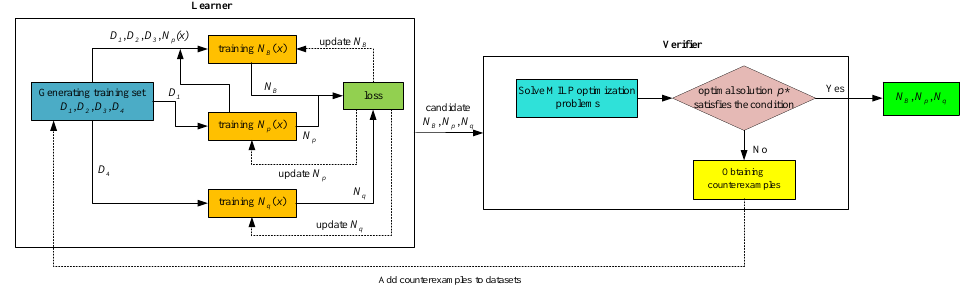
Figure 1. The framework for verifying approximate initial-state